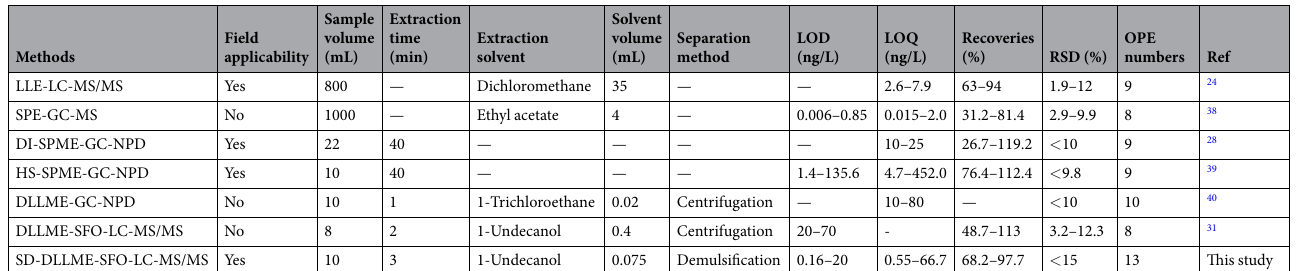
Table 3. Comparison of the proposed method with other methods for determination of OPEs in aqueous